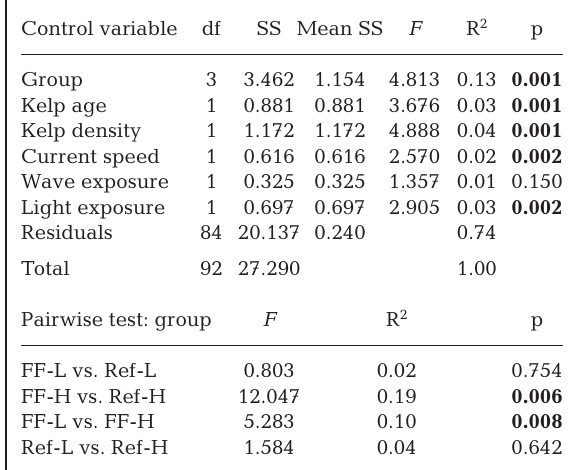
Table 3. Output of PERMANOVA for the epiphytic commu- nity on Laminaria hyperborea stipes collected from fish farm sites (low effluent load: FF-L; high effluent load: FF-H) and reference sites (Ref-L, Ref-H) in the Frøya (Ref-L, FF-L) and Smøla (Ref-H, FF-H) archipelagos. The significance of cho- sen control variables in explaining the variation in the data, and pairwise comparisons of levels within the a priori set factor ‘group’, are shown (p-values based on permutations and adjusted for multiple testing in the former). Bold indicates significance (based on permutations, α = 0.05)